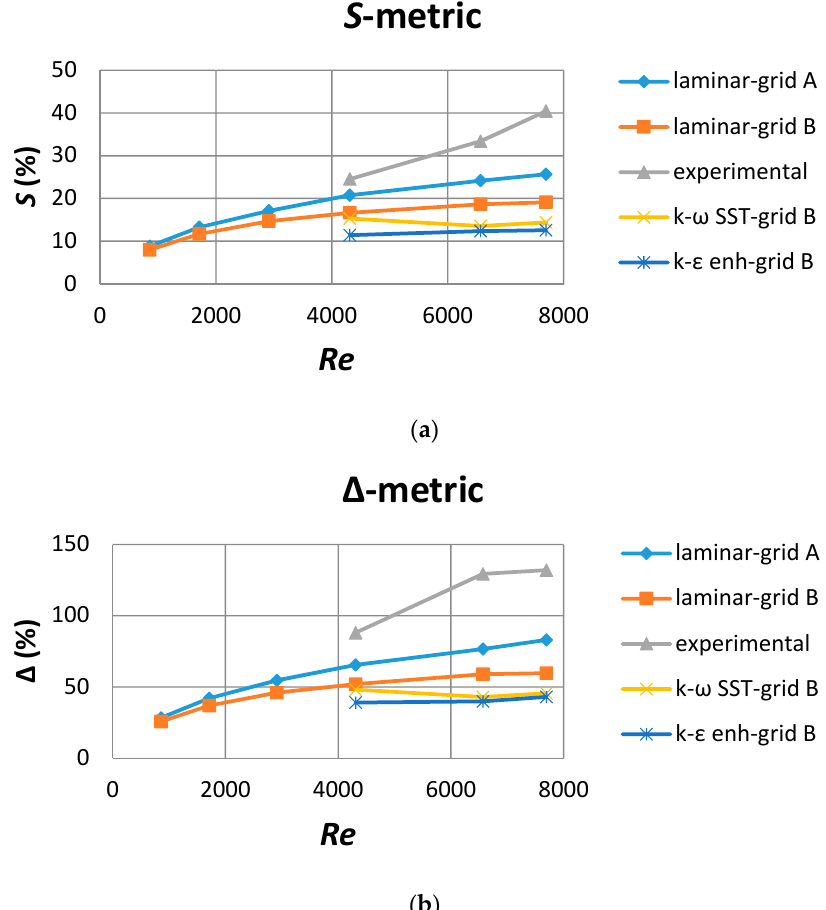
Figure 9. Comparison of uniformity metrics S β and ∆ β (defined by equations (7) and (8), respectively) versus inlet Reynolds number corresponding to the various numerical and experimental results. ( a ) S -metric; ( b ) ∆